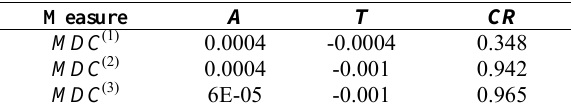
Table 4. Parameters’ values for correlation function used for fitting distribution of the multi-layered degree centrality Measure